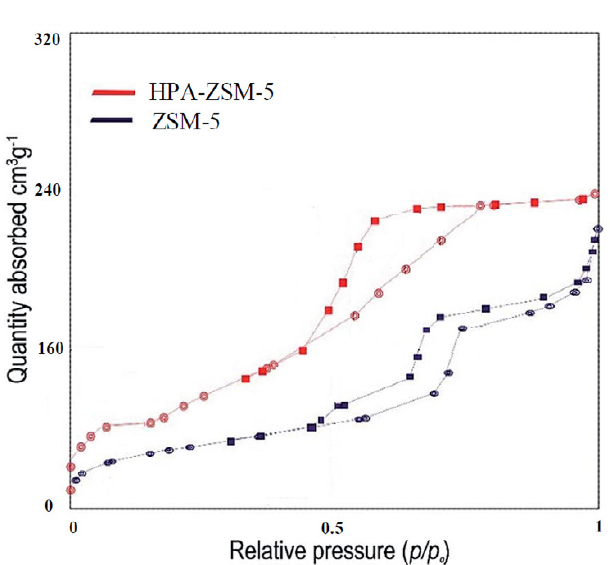
Fig. 4. N adsorption–desorption isotherms of ZSM-5 and 2 Figure 4 . N 2 adsorption–desorption isotherms of ZSM-5 and HPA-ZSM-5